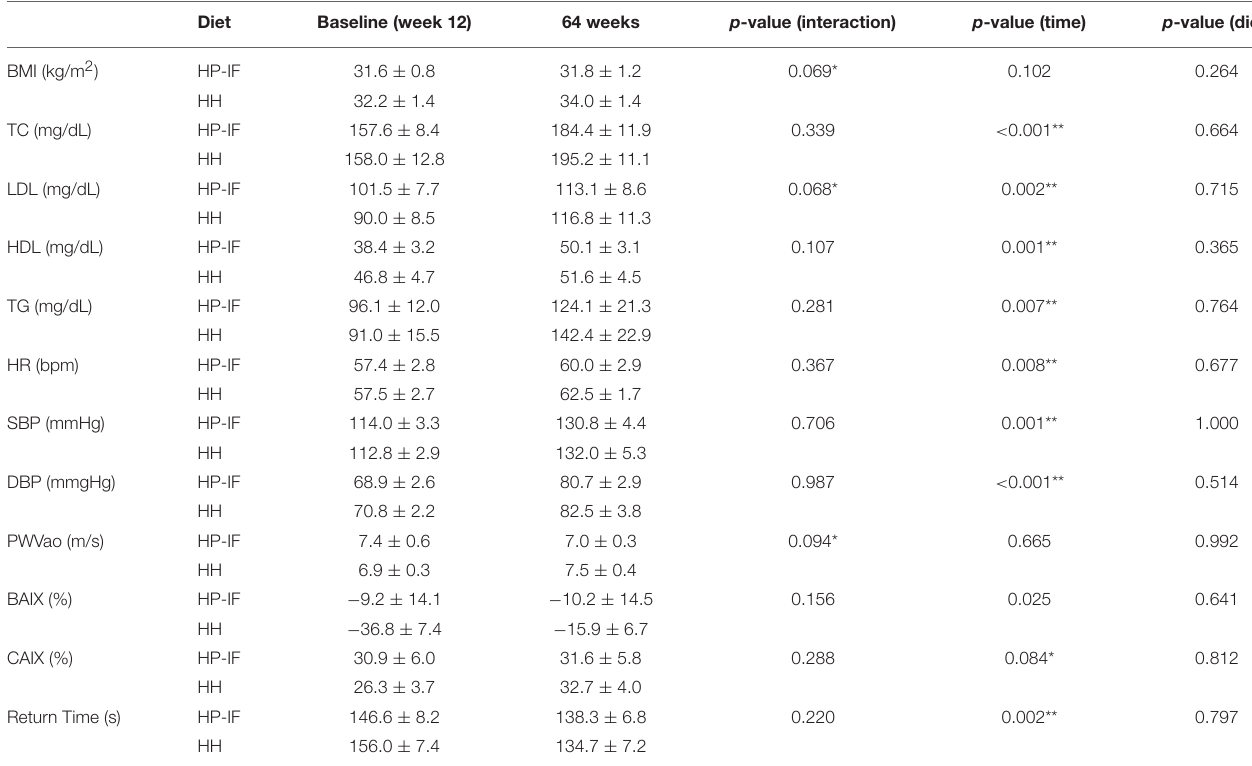
TABLE 7 | Results of weight loss maintenance phase (Phase